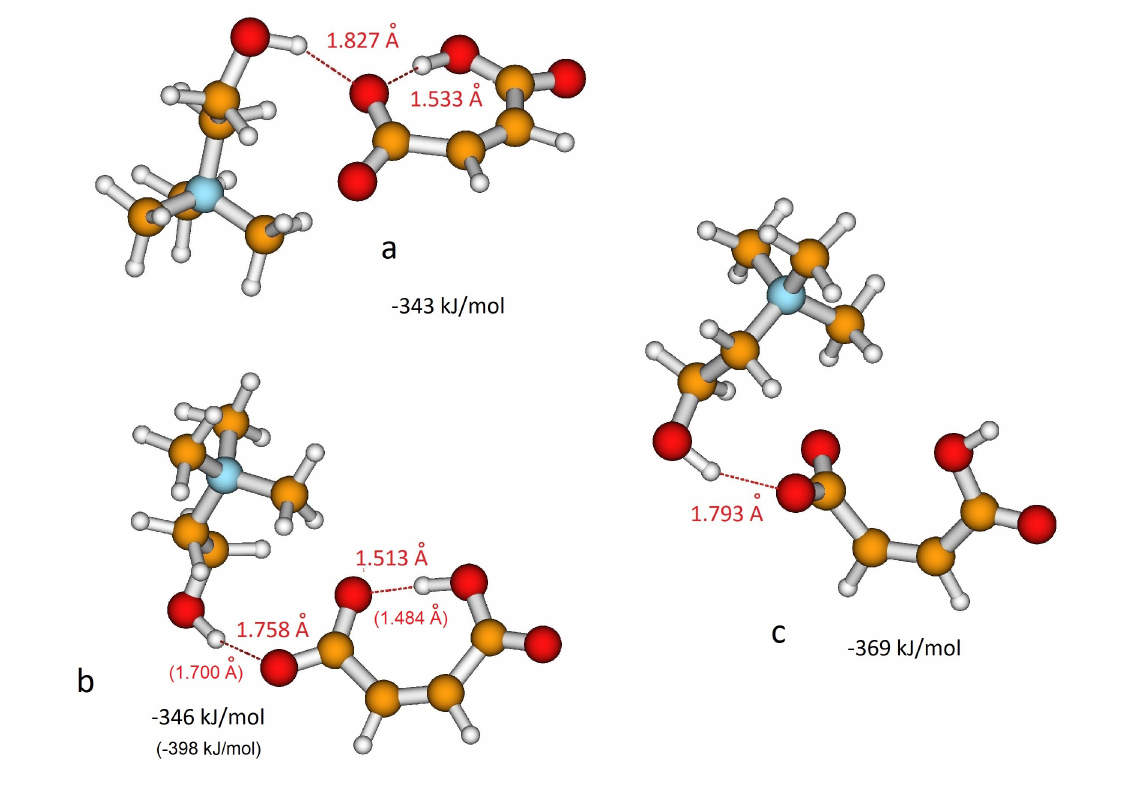
Figure 3. Different coordination structures, ( a ), ( b ) and ( c ), of H-maleate anion and choline cation. Hydrogen bonding distance and binding energy are evaluated from B3LYP/6–311++G** calculations. Values in parentheses are obtained from MP2/6–311++G**